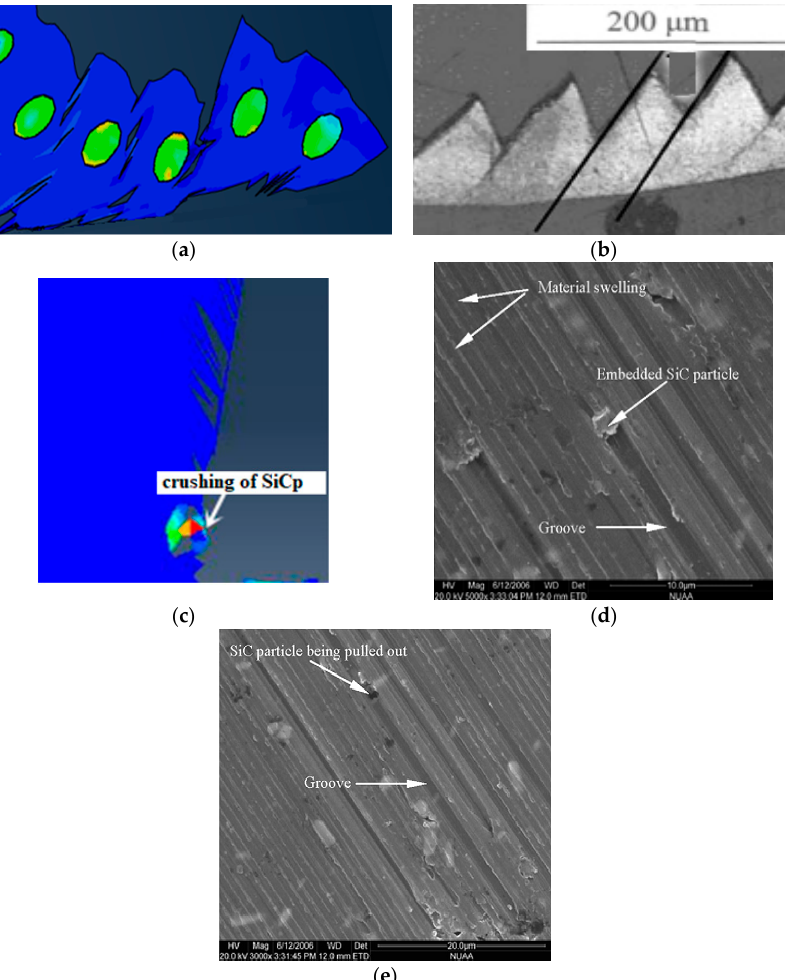
Figure 27. Change of chip geometry at different cutting parameters: ( a ) Simulation of chip morphology, ( b ) actual chip morphology ( v c = 120 m/min), Copyright 2008, Elsevier [37], ( c ) simulation of chip morphology, ( d ) actual chip morphology, and ( e ) magnification at A, Copyright 2009, Elsevier [43].